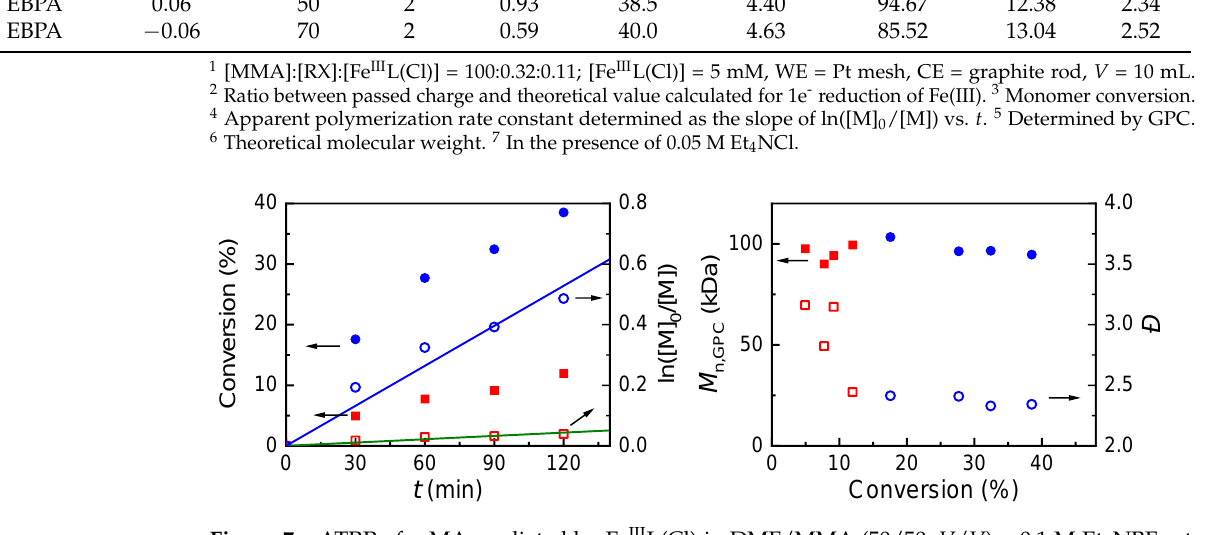
Figure 7. e ATRP of MMA mediated by Fe III L(Cl) in DMF/MMA (50/50, V/V) + 0.1 M Et 4 NBF 4 at T = 50 ◦ C, with ECPA as initiator (squares) at E app = E p or EBPA as initiator (circles) at E app = E p + 0.06 V. Other conditions: [MMA]:[RX]:[Fe III L(Cl)] = 100:0.32:0.11 with [Fe III L(Cl)] = 5 mM.